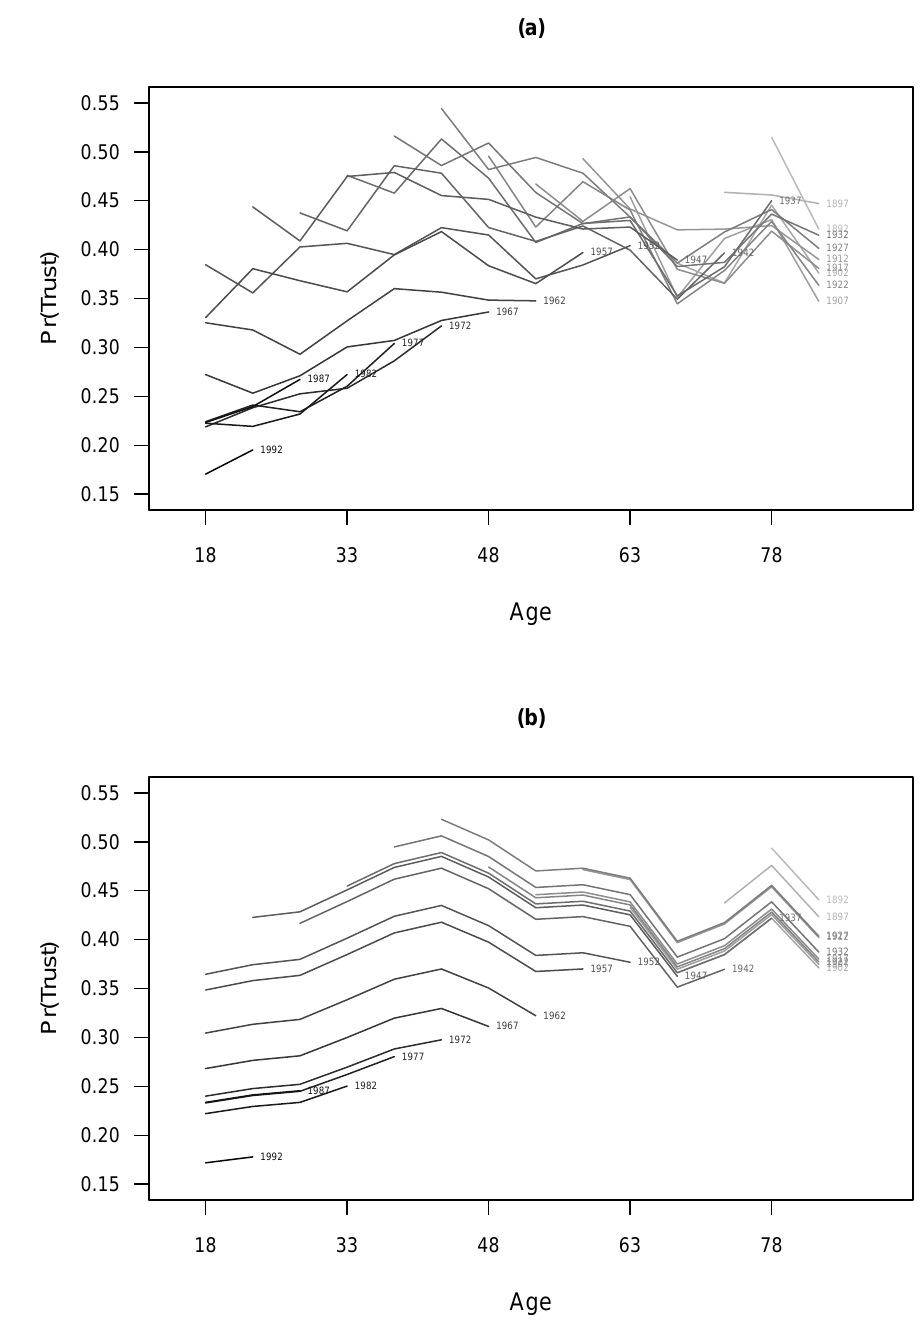
+ k γ k . Only cohorts with (cid:101)